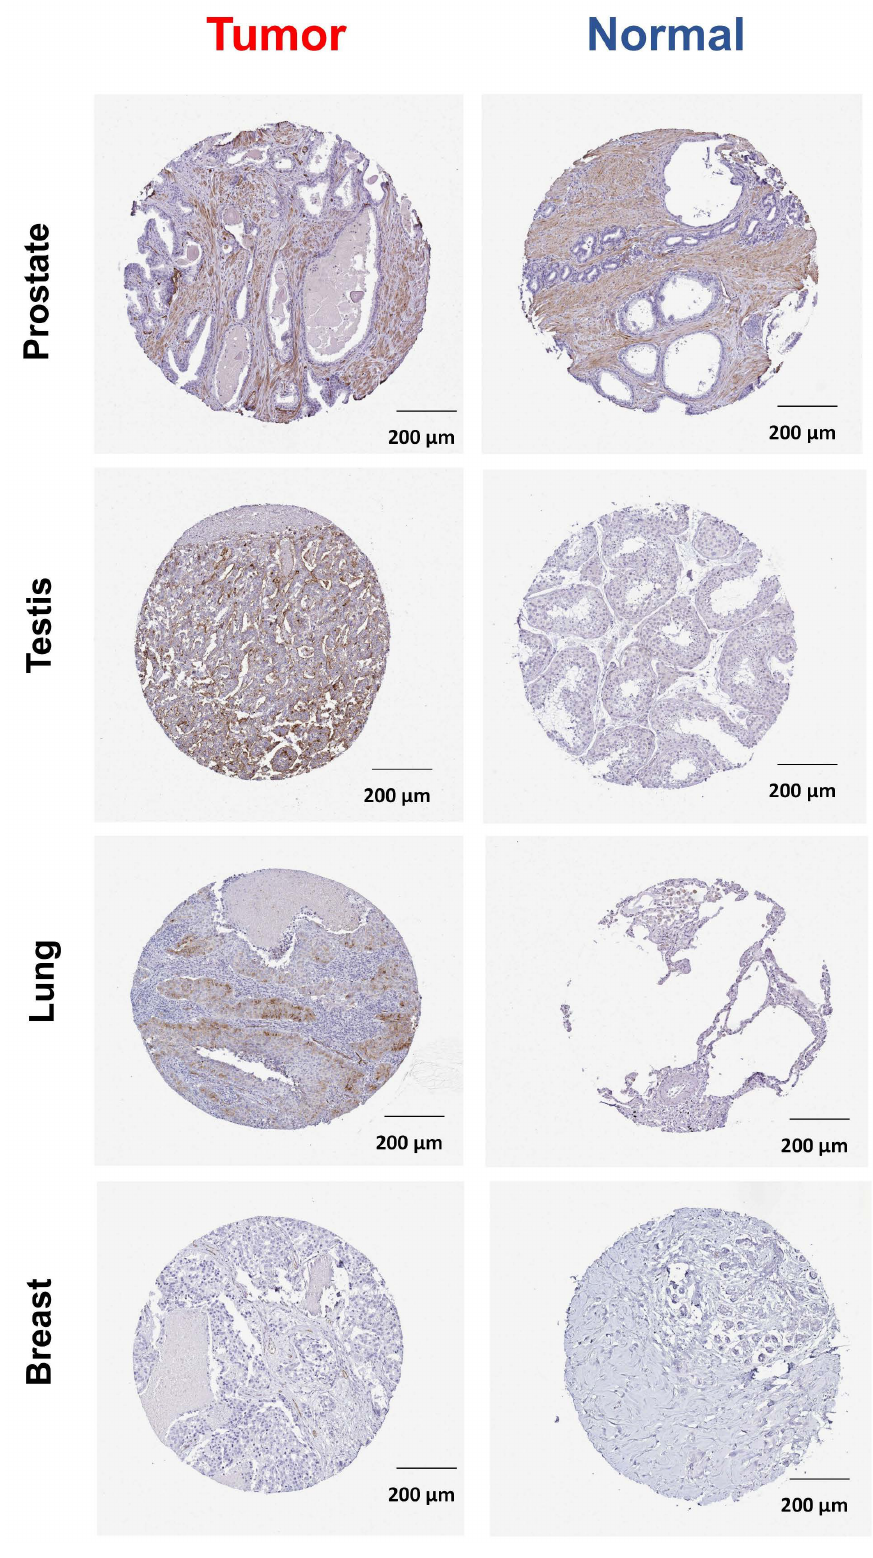
Figure 2. ABCG2 protein expression was shown in immunohistological sections of breast (T: HPA054719 antibody; N: HPA054719 antibody), lung (T: HPA054719 antibody; N: HPA054719 antibody), testis (T: HPA054719 antibody; N: HPA054719 antibody), and prostate (T: HPA054719 antibody; N: HPA054719 antibody), obtained from the Human Protein Atlas